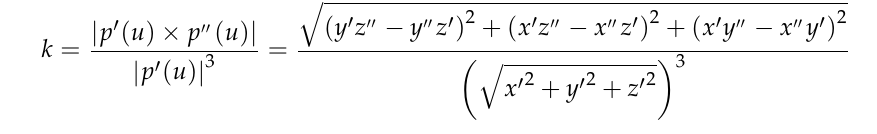
Figure 13. Curvature graph of NURBS and five-degree polynomial planning algorithms.